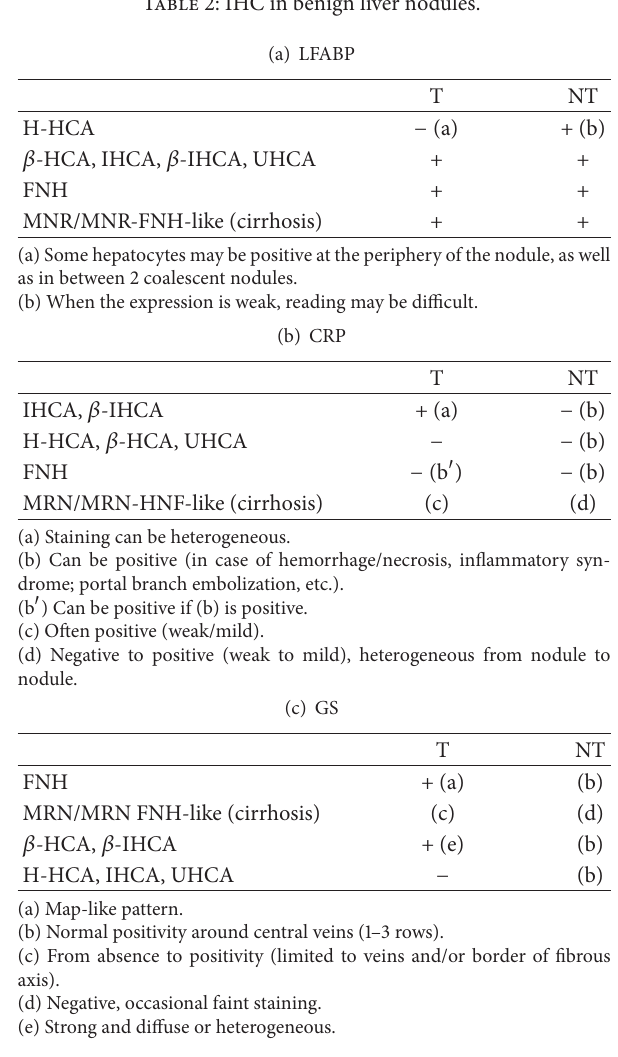
Table 2: IHC in benign liver